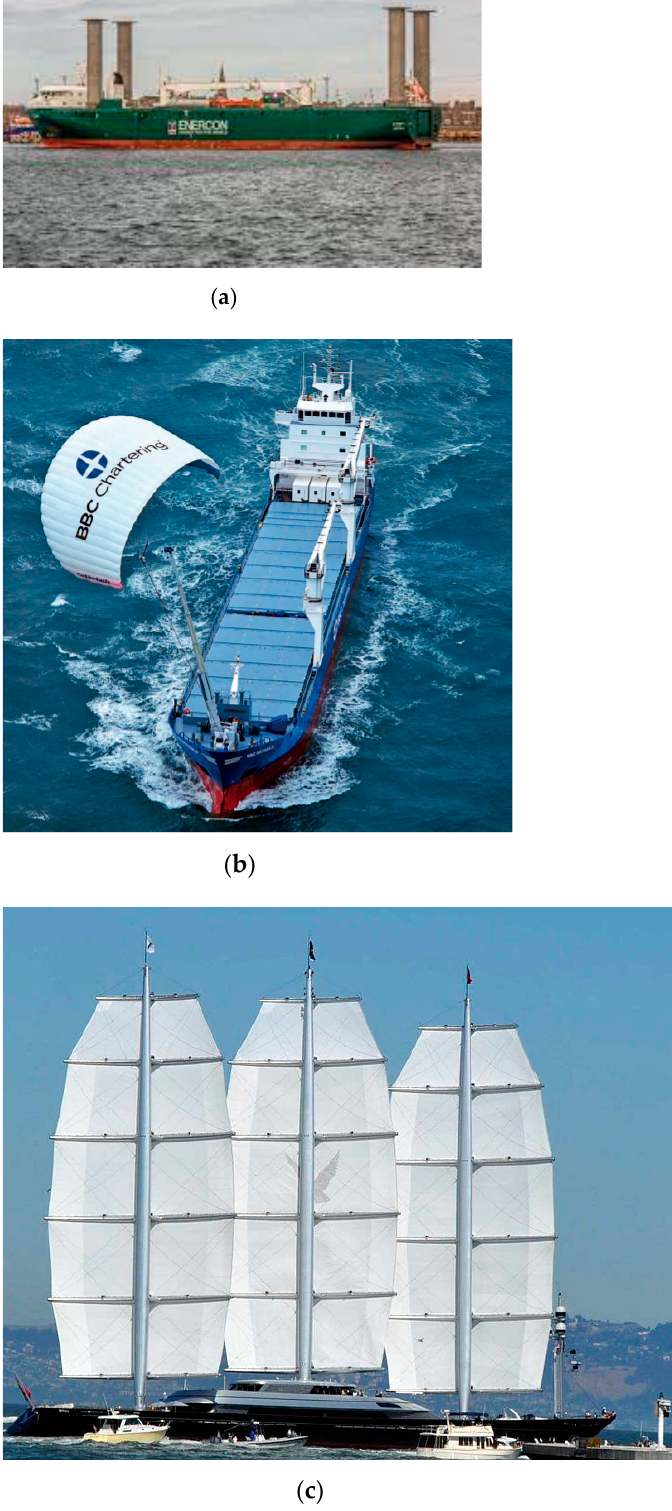
Figure 12. The three mainstream WASPs on board: ( a ) Flettner rotor (Courtesy of Alan Jamieson) (CC BY 2.0); ( b ) Towing kite (Photo reproduced with permission; copyright SkySail Group); ( c ) Soft sail (The Maltese Falcon) adapted from lj16/Wikipedia (https://commons.wikimedia.org/wiki/File: The_Maltese_Falcon_(2906785674).jpg) (CC BY) accessed on 5 January